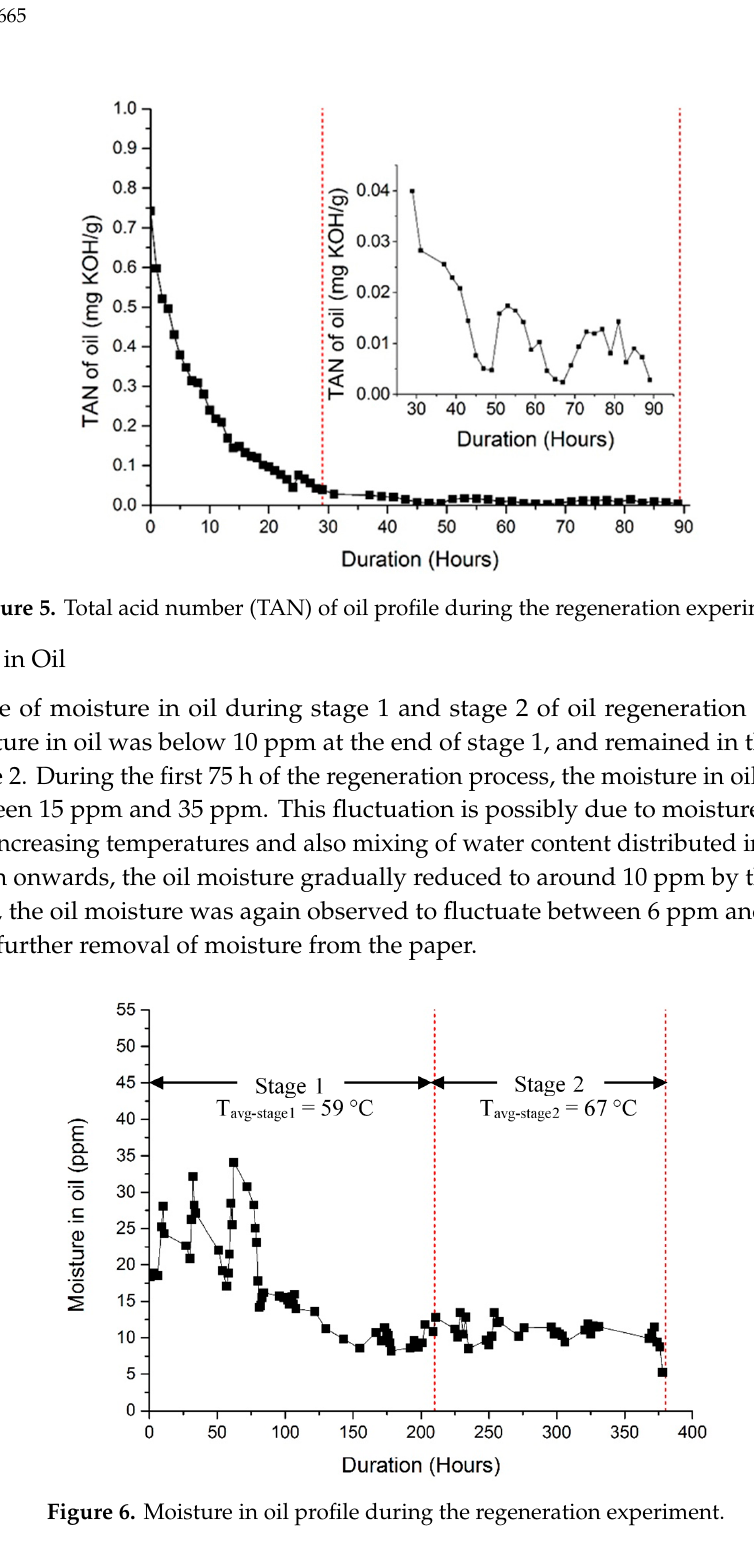
Figure 7. Comparison of moisture in oil measured by KF titration and moisture in oil calculated by solid state sensor, along with oil relative humidity and temperature.